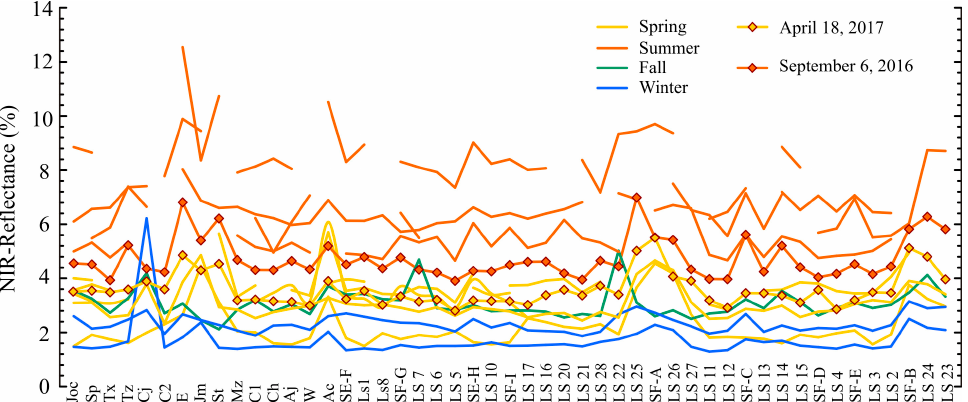
Figure 9. NIR-reflectance at sampling sites classified by season. Tag-descriptions are listed in Table 1, and locations in Figures 1 and 2.